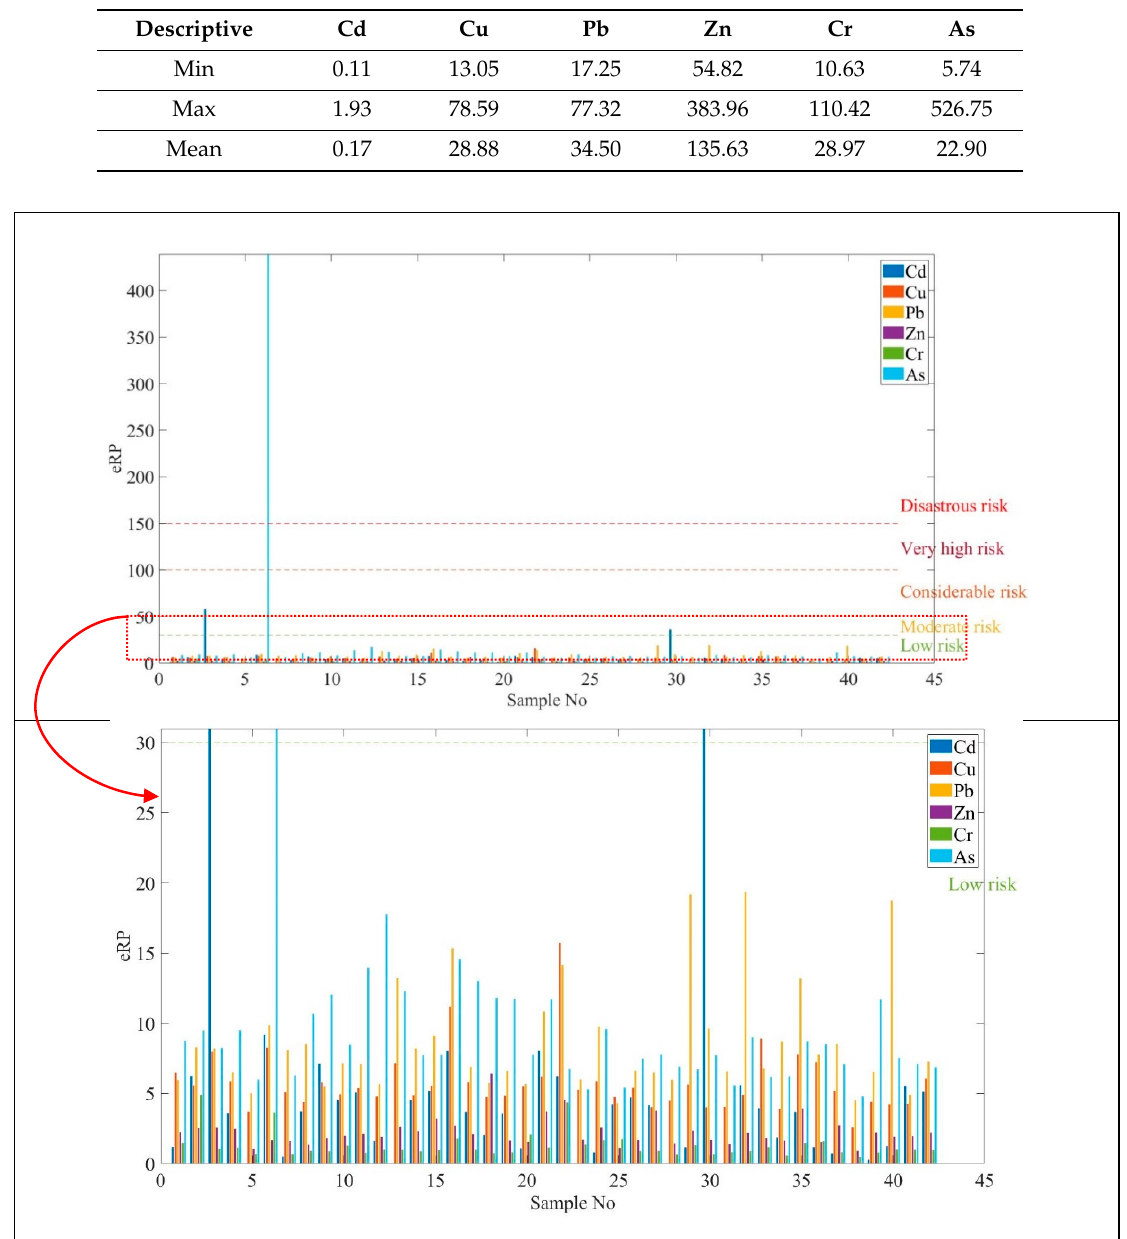
Table 14. Potential ecological risk index of single element ( eRP i ) .